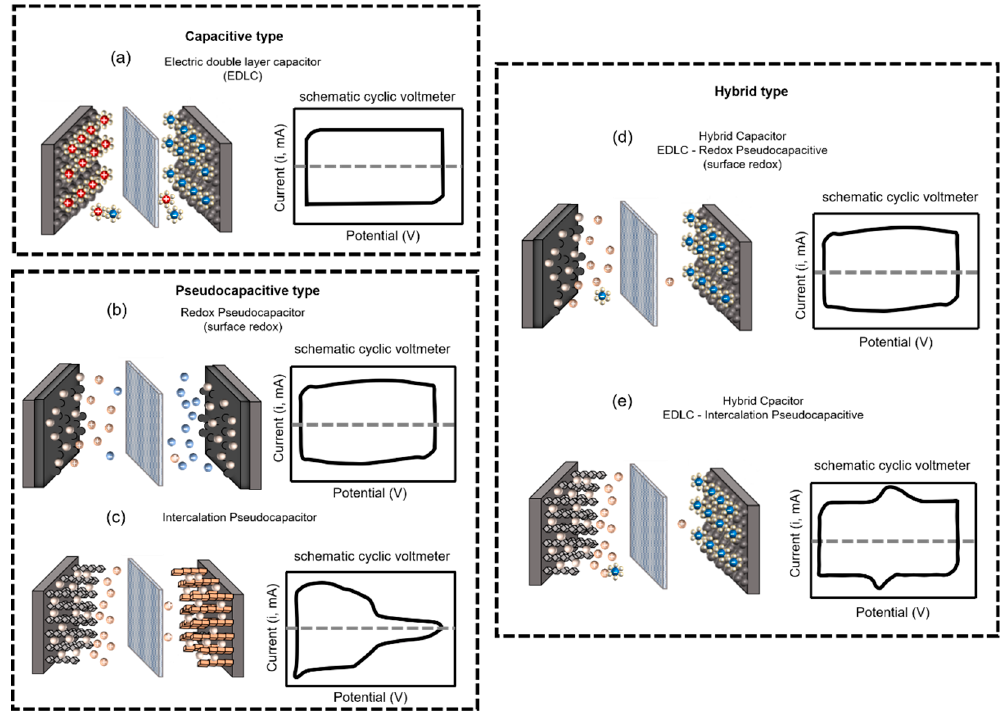
Figure 12. Schematic illustration of a supercapacitor classified by capacitive type. ( a ) Schematic illustration of EDLC, which has cations and anions that are physically layered from electrodes. The schematic cyclic voltmeter has the same shape as a capacitor. ( b ) Schematic illustration of redox pseudocapacitor, which stores and releases energy through chemical adsorption reactions at the surface of the electrode. The schematic cyclic voltmeter is not the same as a capacitor but has a similar shape. ( c ) Schematic illustration of intercalation pseudocapacitor, which stores and releases energy through chemically transform reactions based on the faradaic charge storage mechanism. The schematic cyclic voltmeter shows the characteristics between the capacitor and the battery. ( d ) Schematic illustration of hybrid capacitor integrated both electrode types, which is EDLC and redox pseudocapacitive material. ( e ) Schematic illustration of hybrid capacitor integrated with both electrode types, which are EDLC and intercalation pseudocapacitive material [5,6,10,21,55].